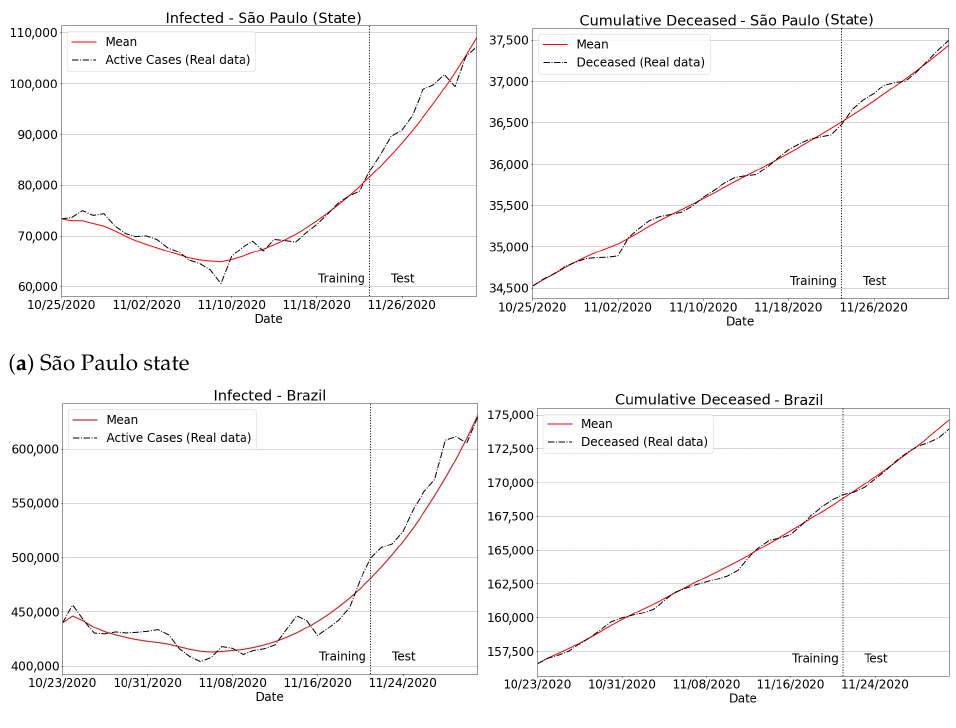
Figure 13. Infected and deaths for São Paulo state and Brazil over recent data. The high increase in both indicators suggests the eminence of a “second wave” of coronavirus hitting the country and starting in the second half of November.